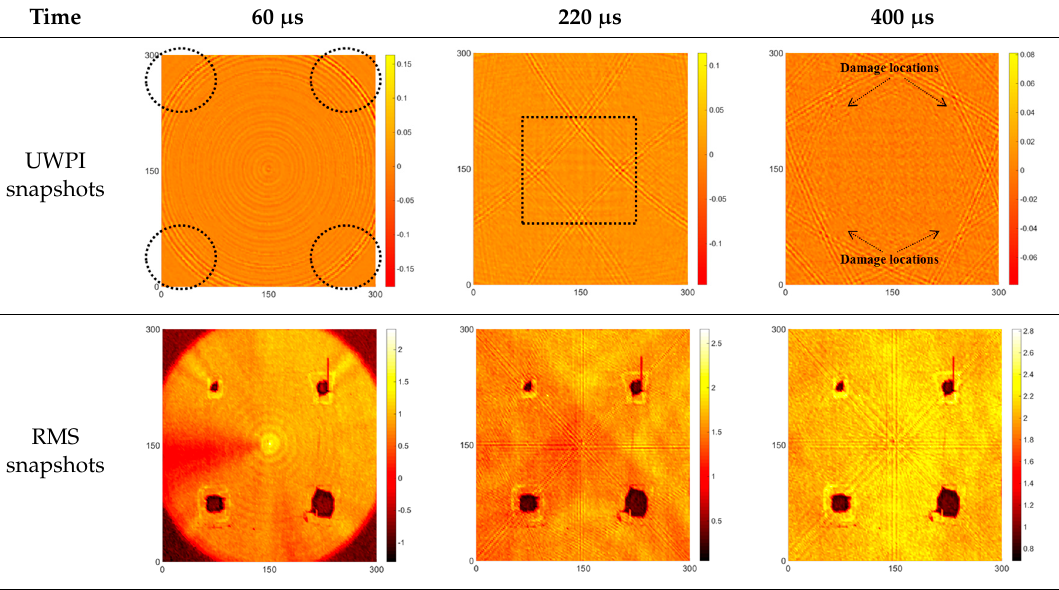
the following order: bottom left, bottom right, top left, and top right. This order follows the depth of corrosion from deep to shallow, so damage detection on the back side shows a lighter color (a larger